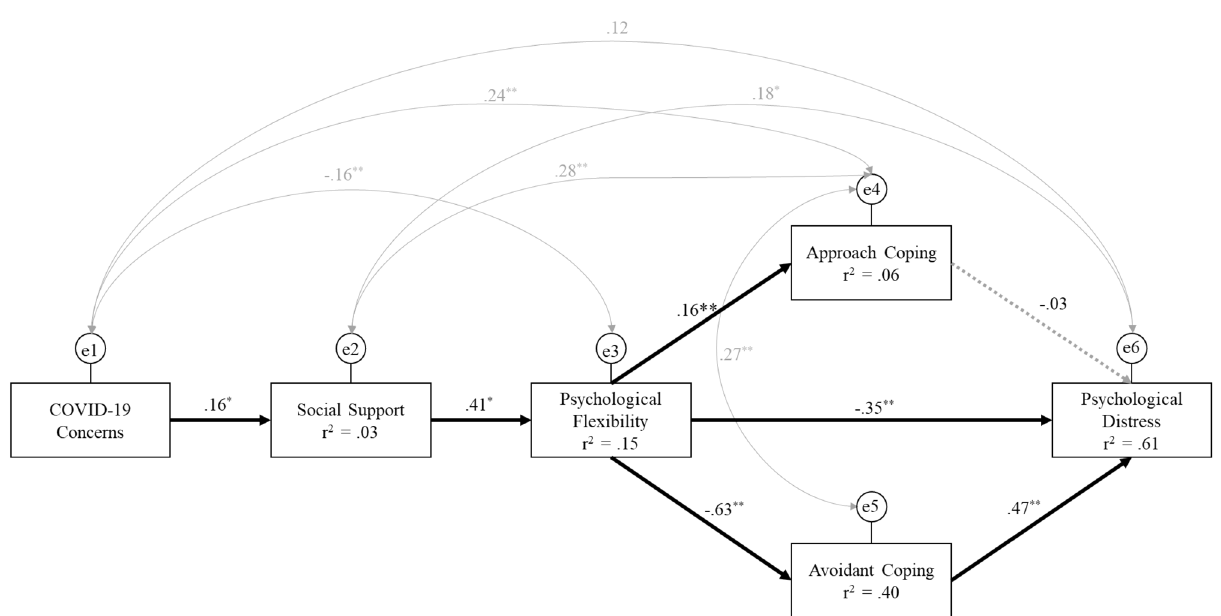
Figure 2. The final model predicts the pathway from COVID-19 concerns, social support, psychological flexibility, approach coping styles, avoidant coping styles, and psychological distress. Solid lines represent significant pathways, and dotted lines represent non-significant pathways. All values are standardised beta weights. * p < 0.05; ** p < 0.01; *** p <